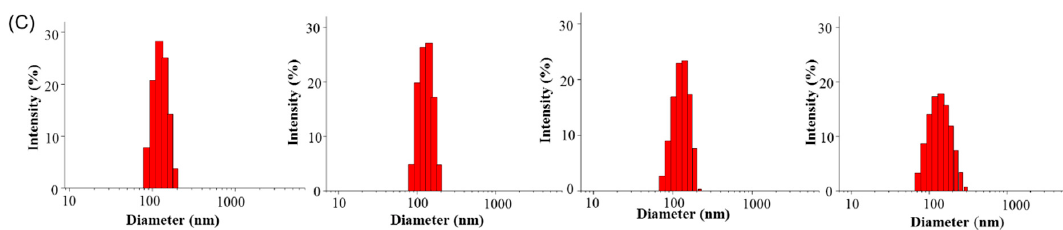
Figure 3. Particle size distribution of PEG-PLLA/PDLA-PNIPAM polymer micelles in PBS solutions of pH 1.2, 6.8, and 7.2, respectively, in 48 h (from left to right are 0 h, 6 h, 12 h, and 48 h, respectively).